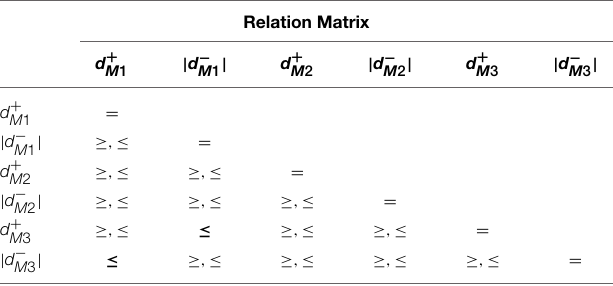
TABLE 2 | The relation matrix of Case Study 1. Relation Matrix